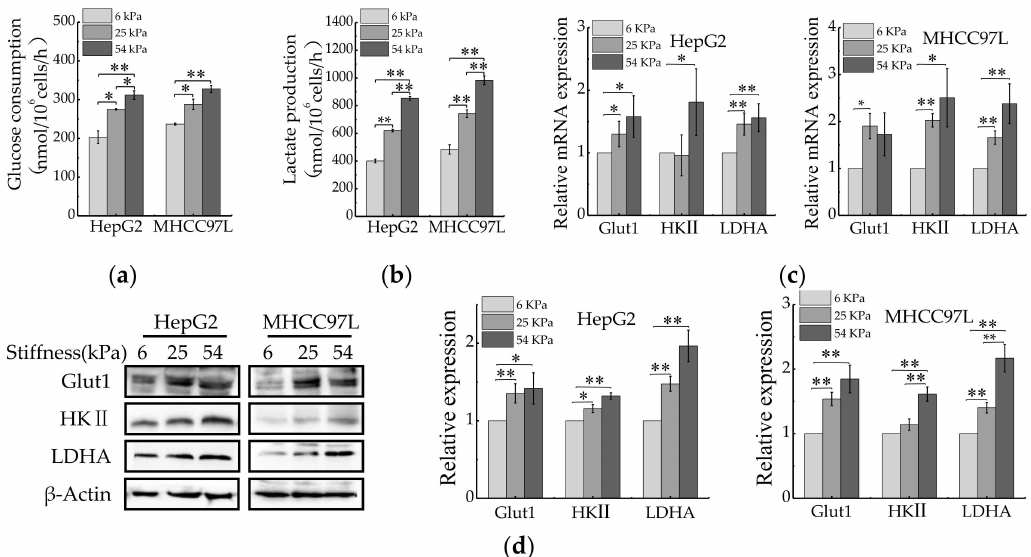
Figure 2. Aerobic glycolysis of HCC cells is regulated by ECM sti ff ness. ( a , b ) Measurement of glucose consumption ( a ) and lactate production ( b ) of HepG2 and MHCC97L cells cultured on di ff erent sti ff ness of hydrogel for 48 h. ( c ) qRT-PCR analysis of indicated genes mRNA levels in HCC cells. ( d ) Western blot analysis of indicated protein levels in HCC cells. ( n = 3, * p < 0.05, ** p < 0.01).